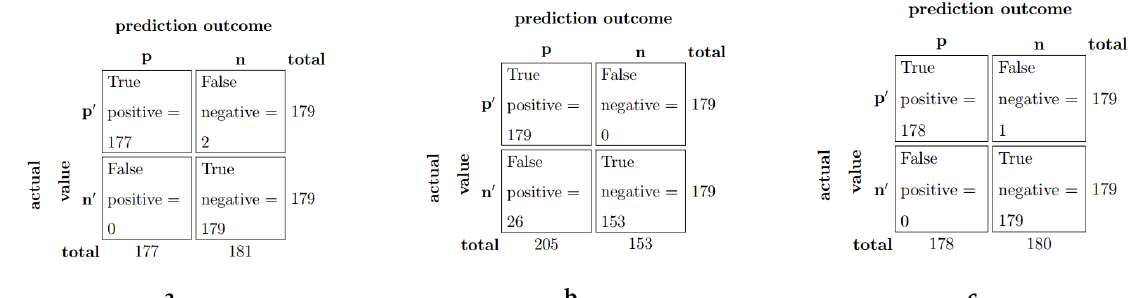
CNN | 2 Figure 11. In our case, both CNN | 1 Scratch and Scratch have 2 false negatives and no false positives. The final ensembled model is almost perfect. ( a ) Confusion matrix of both CNN | 1 Scratch and CNN | 2 Scratch in the test dataset. ( b ) Confusion matrix of CNN | Xfer in the test dataset (no false negatives.) ( c ) Confusion matrix of the ensembled model in the test dataset (no false positives).